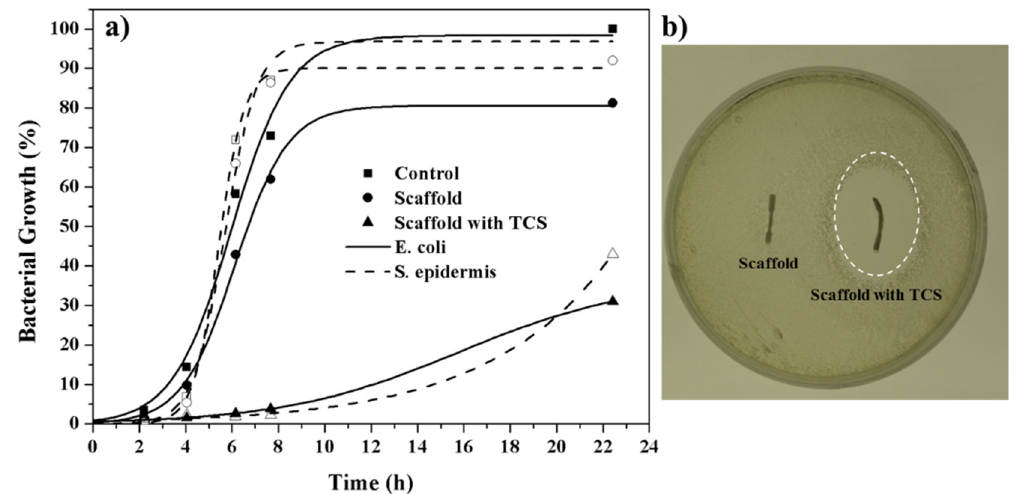
Figure 15. ( a ) S. epidermidis (dashed lines) and E. coli (solid lines) bacterial growth profiles in presence of non-porous PLA control), PLA scaffold and PLA scaffold loaded with 6 wt-% of TCS. ( b ) Agar test for E. coli bacterium using PLA scaffolds with and without the TCS antibacterial drug.